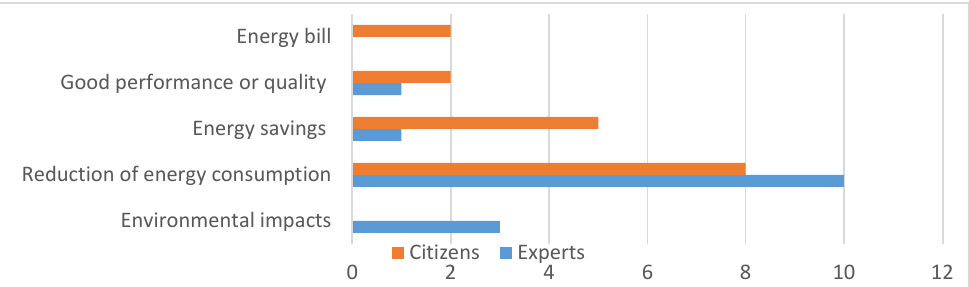
Figure 2. Concepts related to EE according to members of the public and experts.